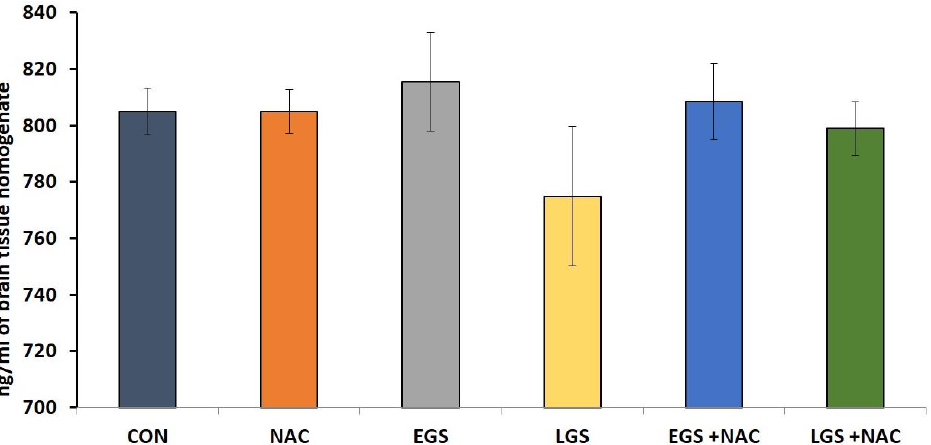
Figure 4. Effect of prenatal stress and NAC on whole brain homogenate serotonin levels (nmol/mL) at PND 36 in rat offspring. One-way ANOVA, Tukey-Kramer Multiple Comparisons Test, each bar represents mean ± SEM, n = 12. Data are expressed as mean ± SEM.